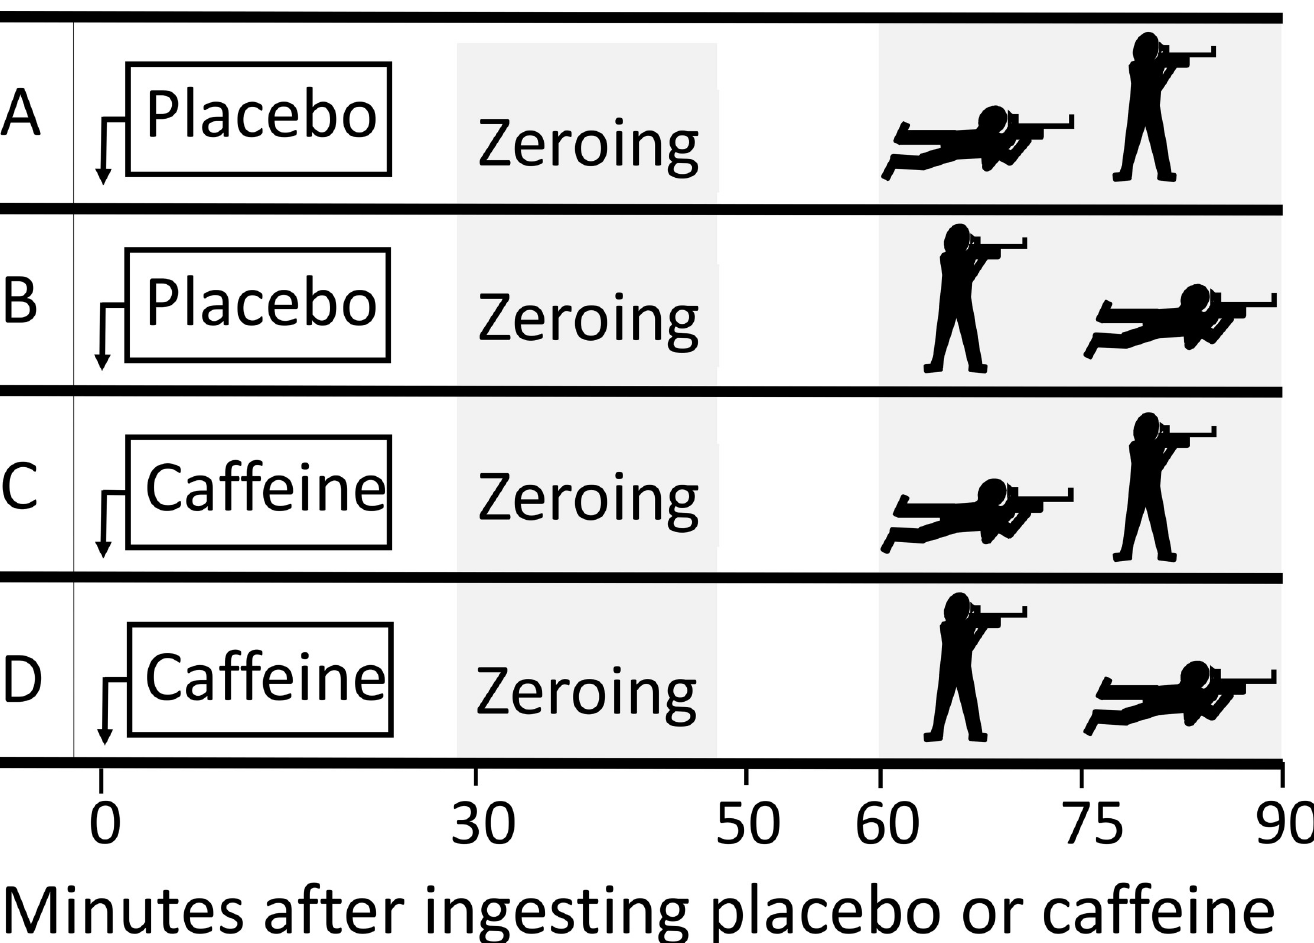
Fig 1. Overview of the shooting tests. In random order, each participant underwent 4 tests (A, B, C and D) on 4 different days, 2 with placebo and 2 with caffeine ingestion 60 minutes prior to start of the shooting tests. One of the tests with caffeine and one of the tests with placebo started with shooting in prone position before shooting in standing position and the other way